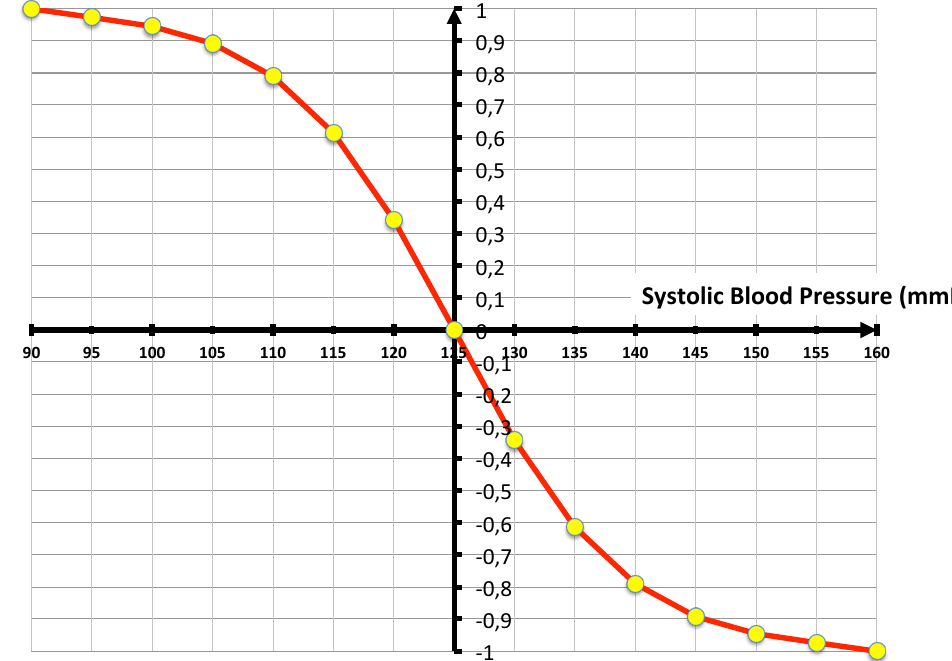
Figure 23. Fuzzy characteristic function low blood pressure µ LBP ( H ( x , t ) risk of